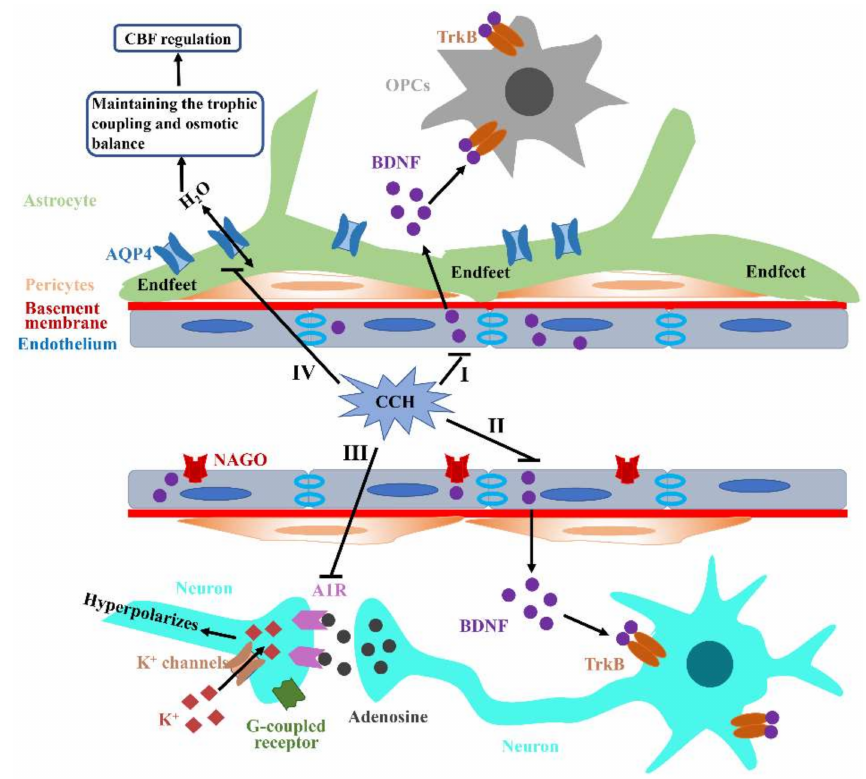
Figure 3. A β accumulation and aggravation under CCH. ( I , II ) The abundant BDNF produced by endothelium in the NVU can bind to TrkB receptors on OPCs and neurons to promote their proliferation, migration and survival, which can be disrupted by CCH. ( III ) CCH can significantly decrease A1R expression and subsequently impede neuron hyperpolarizes in the post-synapse through G-protein coupled inwardly rectifying K + channels. ( IV ) AQP4, as a water channel, is generally restricted to astrocytic end-feet processes that mainly contact synapses and vasculature. Additionally, AQP4 also plays an important role in maintaining osmotic balance through eliminating edema induced by various damages. CCH can lead to AQP4 mislocalization and then induce extensive trophic uncoupling and osmotic imbalance, ultimately destroying CBF regulation and attenuating perfusion to the